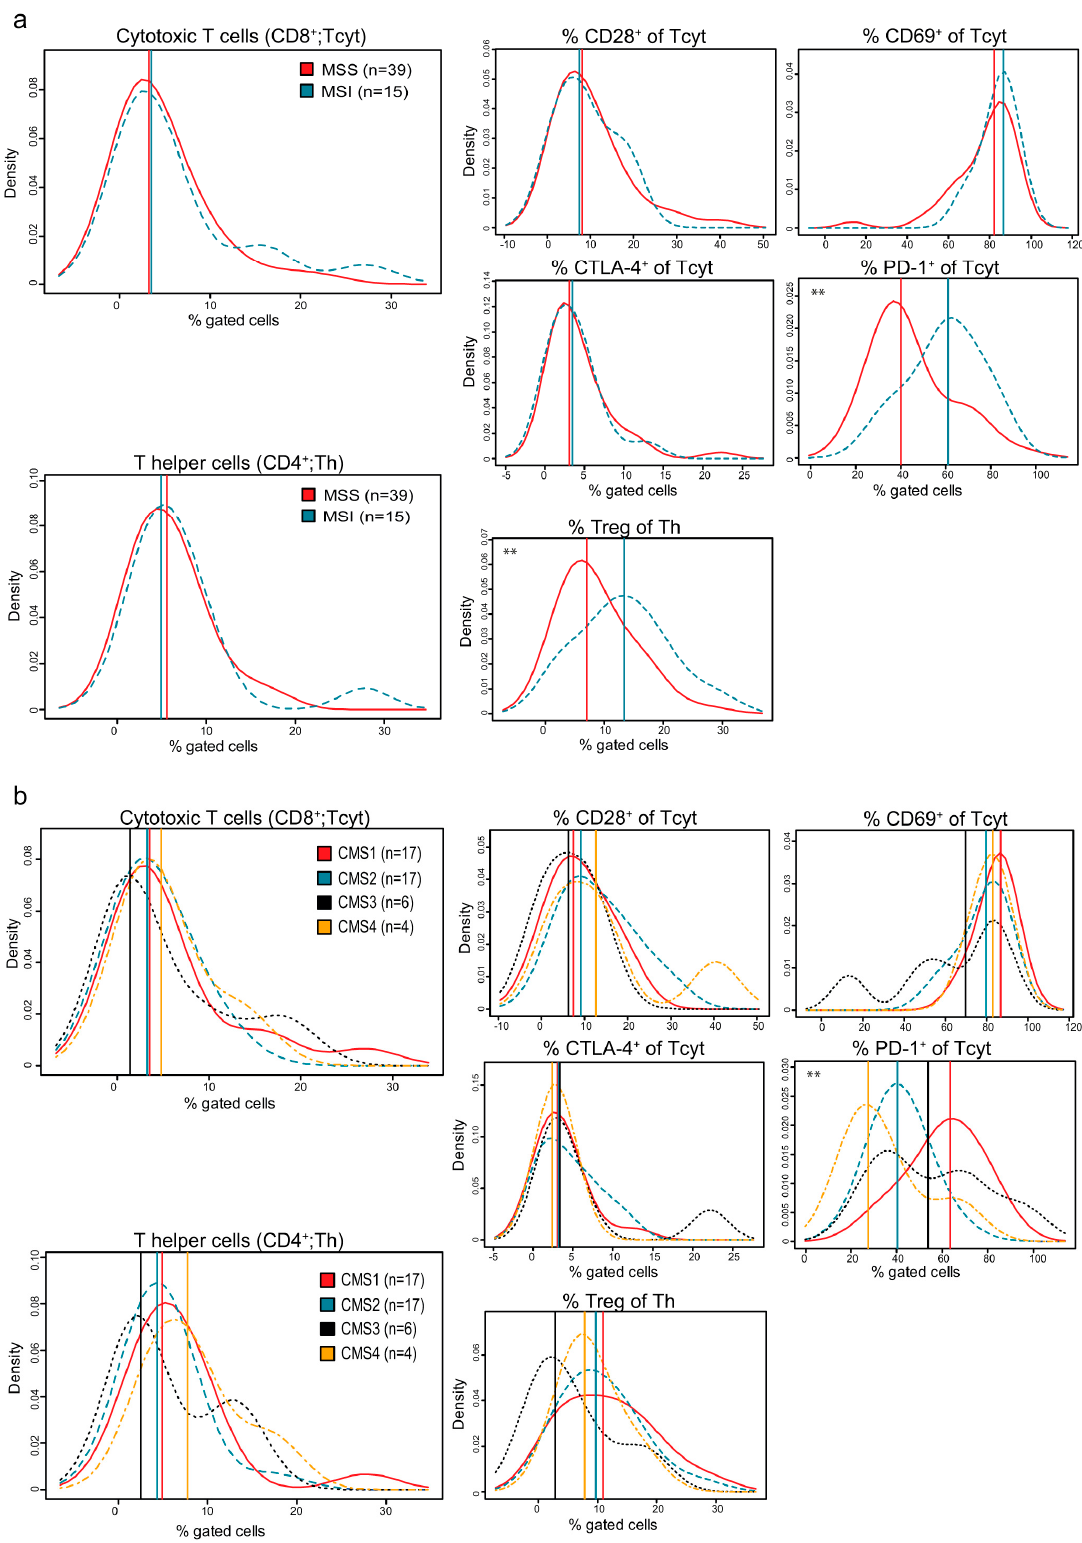
Figure 3. Density plots illustrating the distribution of indicated immune markers predicted by ( a ) MSI / MSS subgroup and ( b ) CMS subgroup. Vertical lines indicate median values. ** indicates p -values < 0.05.